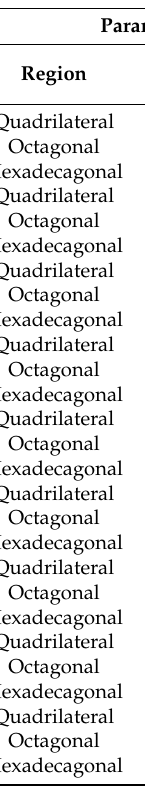
Table 6. PSNR improvements for ankle X-ray images denoised using the proposed 2D LPA-RICI method vs. the competitive